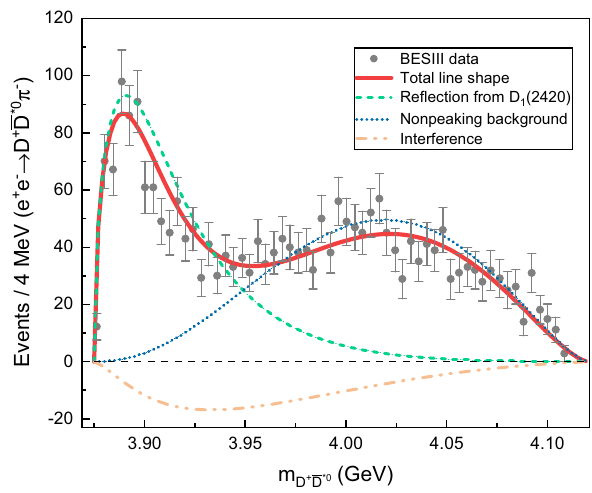
Fig. 2 The fit to the experimental data of e + e − → D + ¯ D ∗ 0 π − by line shapes on the spectrum of m [11], where the structure near D + ¯ D ∗ 0 the threshold of D + ¯ D ∗ 0 corresponds to the reported Z c ( 3885 ) + . Here, included are only the reflection from charmed meson D 1 ( 2420 ) and normal nonpeaking contributions together with their interference